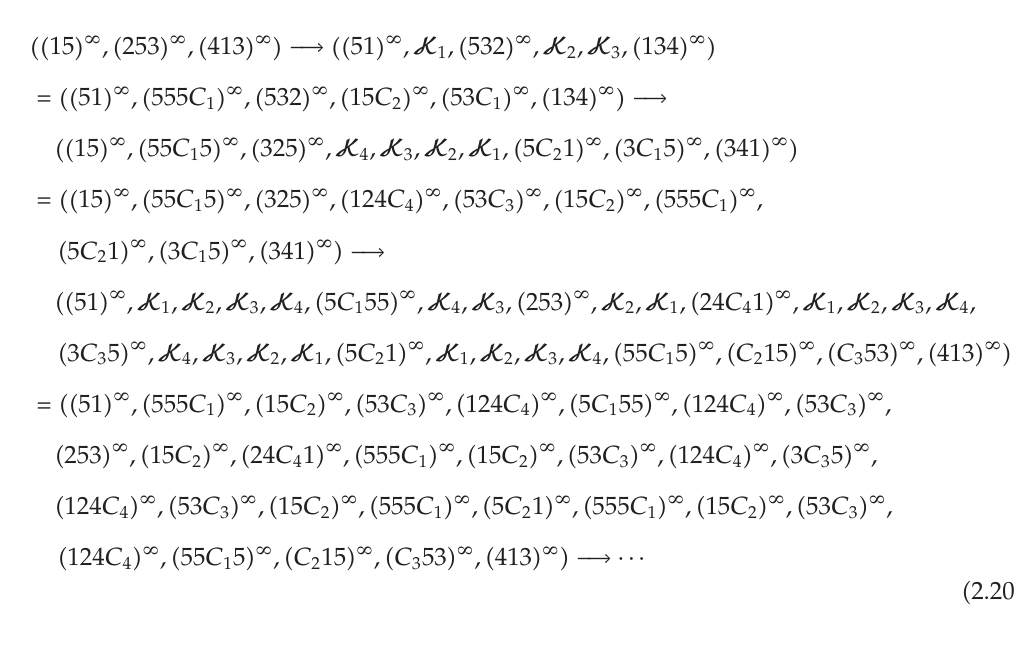
Algorithm 3.1 (cid:2) to compute the itineraries of all critical values of φ n (cid:3) . Let K 1 , K 2 , X 0 , and n